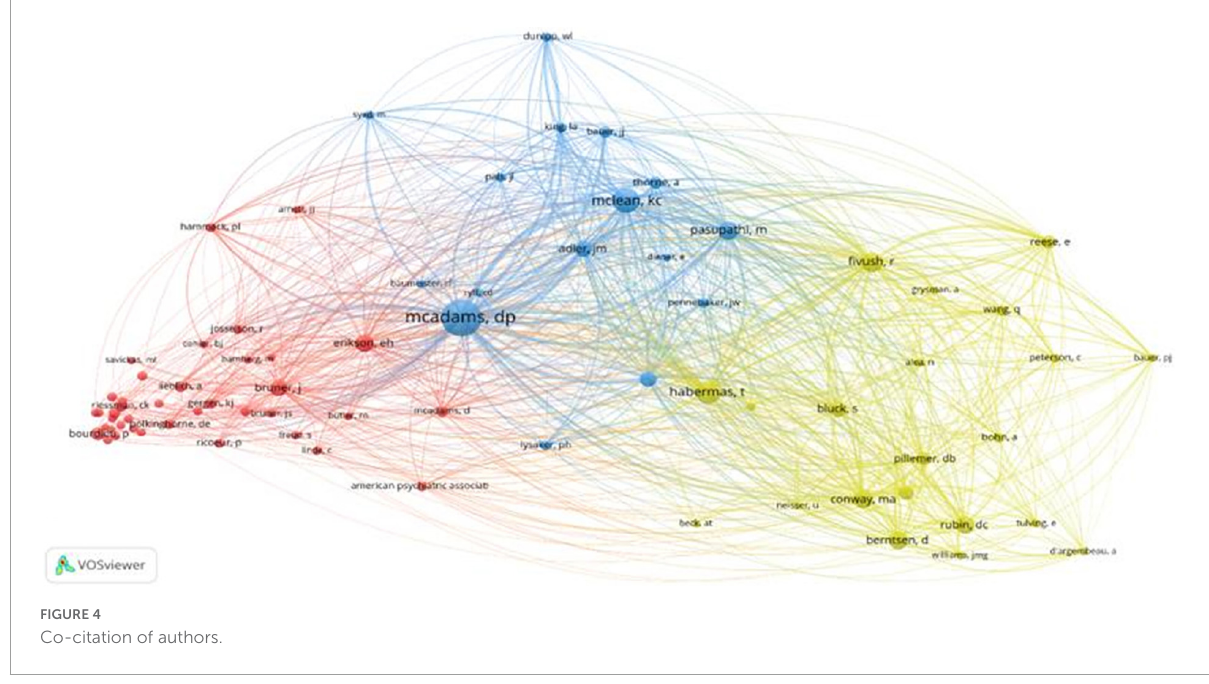
FIGURE4 Co-citation of authors.